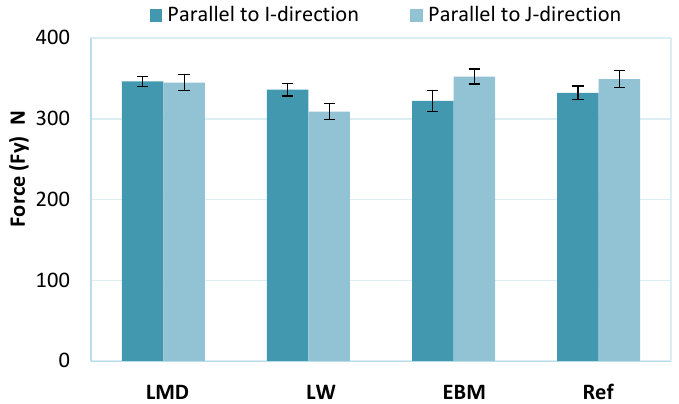
Figure 9. Forces perpendicular to the feed in the Y-direction for the LMD, LW, EBM, and reference (Ref) materials.